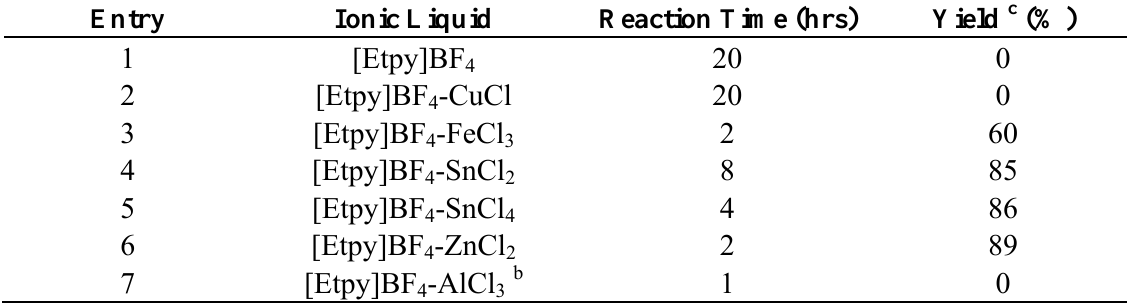
Table 3. Catalytic activities of Friedel–Crafts alkylation reaction with various ionic liquids a . Entry Ionic Liquid Reaction Time (hrs) Yield c (%)